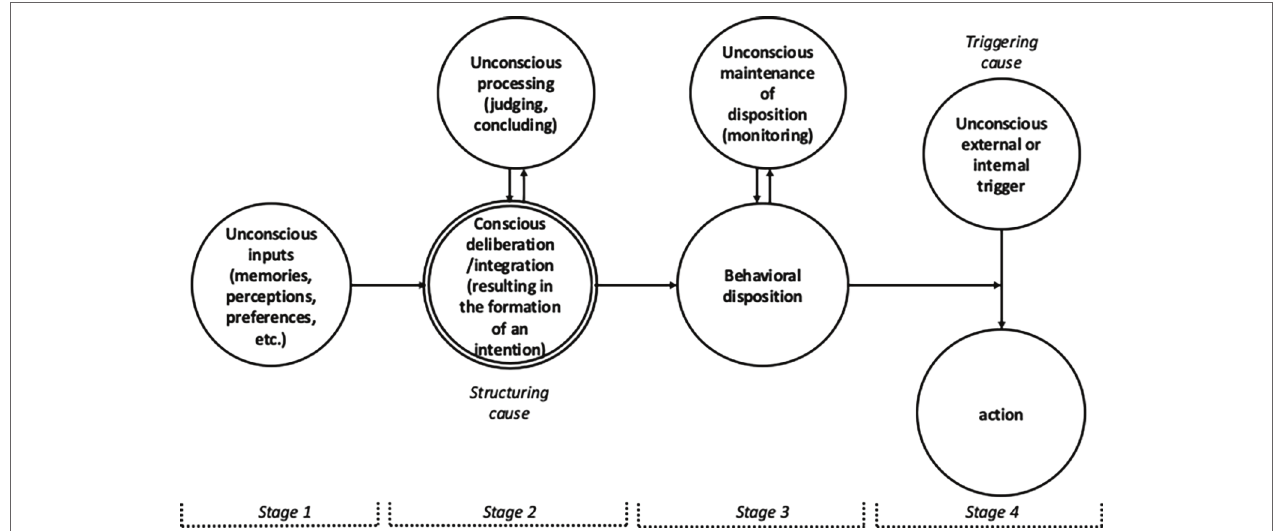
FIGURE 1 | Schematic overview of the interplay between conscious and unconscious processes in consciously self-initiated